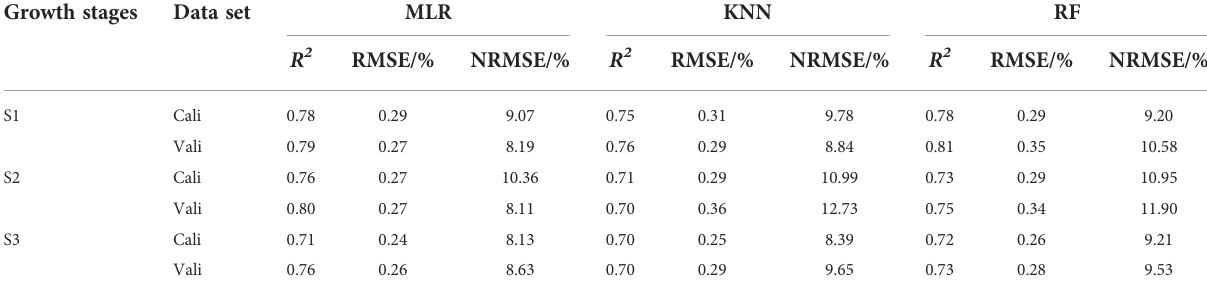
TABLE 4 Estimation of the potato PNC by visible light vegetation indices combined with morphological parameters. Growth